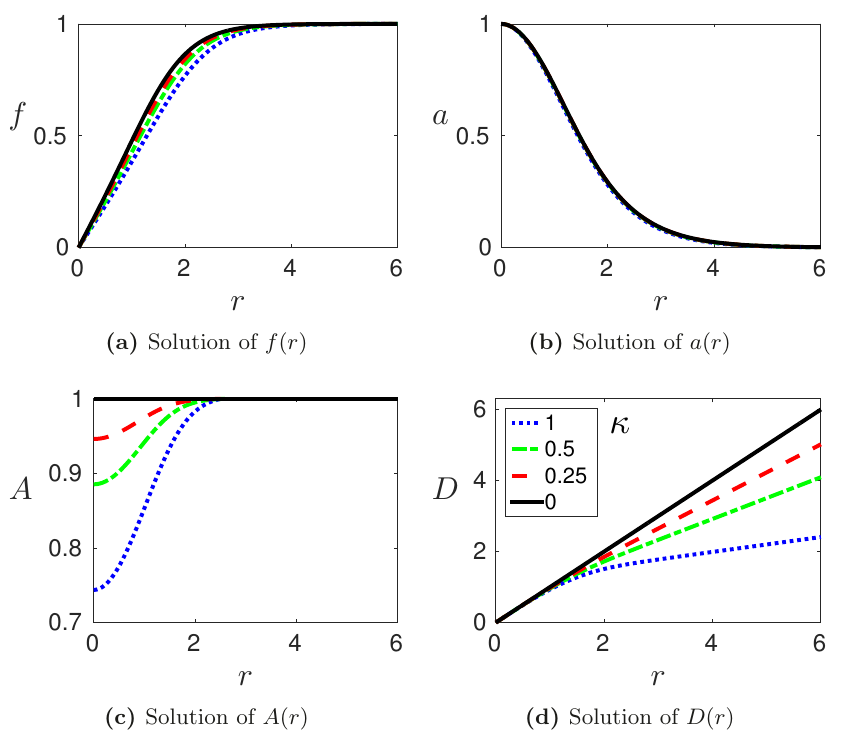
Figure 2. Thick-wall solutions of f ( r ), a ( r ), A ( r ) and D ( r ) respectively. n = e/ √ 4 π = 1, ǫ = 0 . 1. The line patterns (solid line, dashed line, dash-dotted line, dotted line) correspond to κ = (0 . 00 , 0 . 25 , 0 . 50 , 1 . 00),